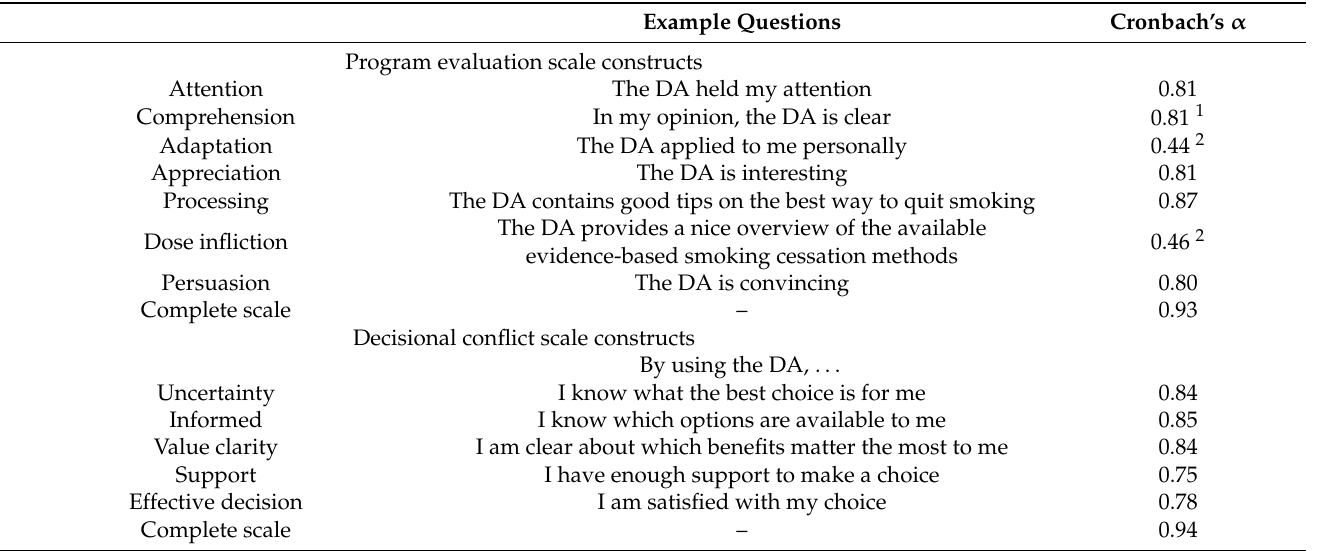
Table 1. Constructs of the program evaluation scale and decisional conflict